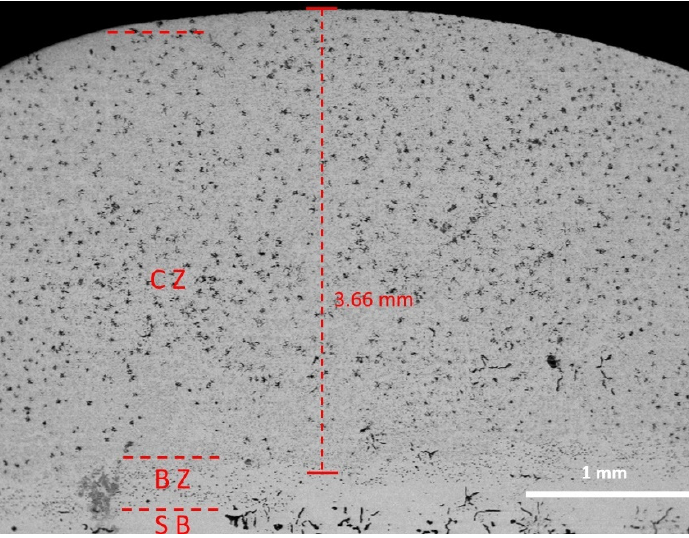
Figure 4. Cross-sectional micro-structure of the iron-based alloy coating prepared with a 50 A plasma arc current.